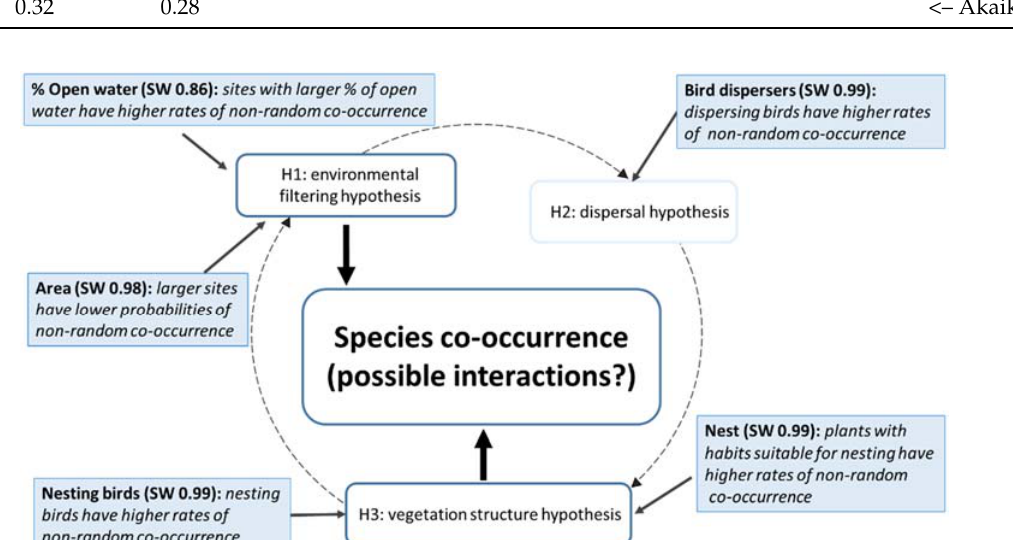
Figure 2. Interdependence of the three hypotheses (H1–H3) in determining species co-occurrences at site-, bird- and plant-level. Each hypothesis is supported by predictors with different variable importance (sum of Akaike weights, SW). Accordingly, the three hypotheses were ranked as contributors of the final species co-occurrence rates and possible species interactions.